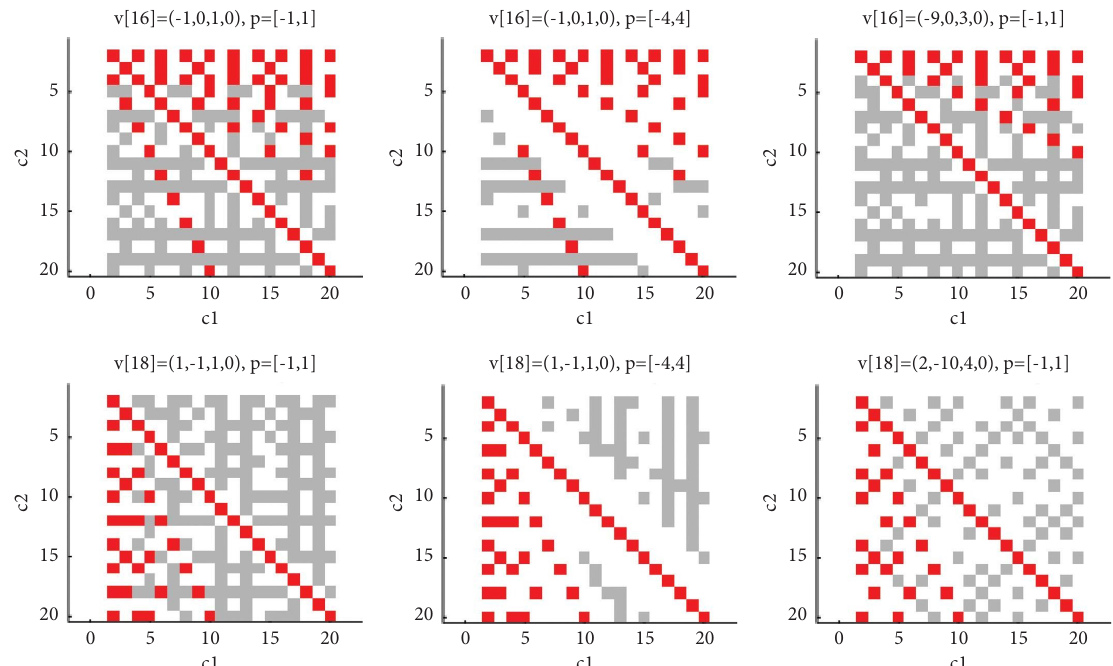
Figure 3: Attractors for tuples v and v from Proposition 1. Here, one of the global ftness functions is constant ( F 16 18 F ( c ,c ) � 1 for v ), while the other species has a bamboo-like behavior—it emerges as an integer multiple of the constant one. In both 1 1 2 18 cases, there is a “commensalism”